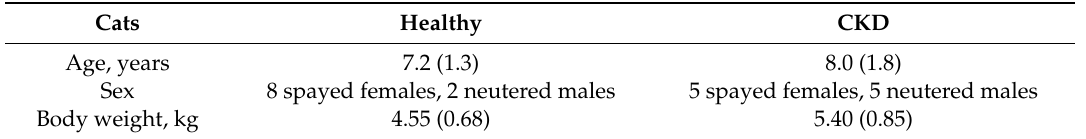
Table 4. Demographic data, mean (standard deviation), at baseline for healthy adult cats (n = 10) and cats with IRIS stage 1, 2, and 3 chronic kidney disease (CKD; n =